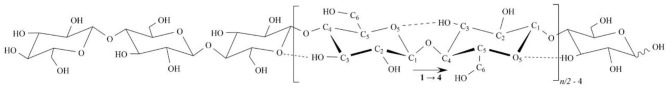
Chemical structure of cellulose molecule (n = degree of polymerization).